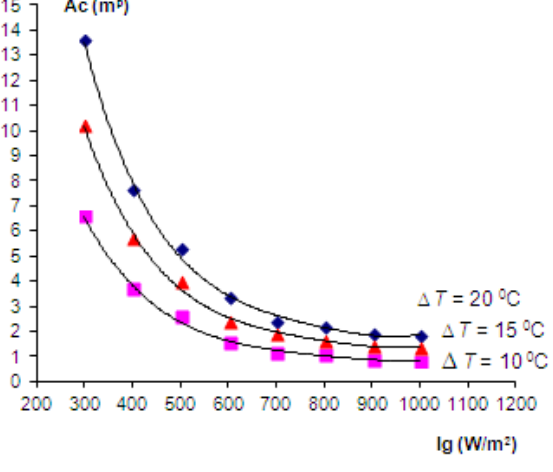
Figure 8. Area of solar air collectors versus solar radiation for three fields of temperature for a family house.